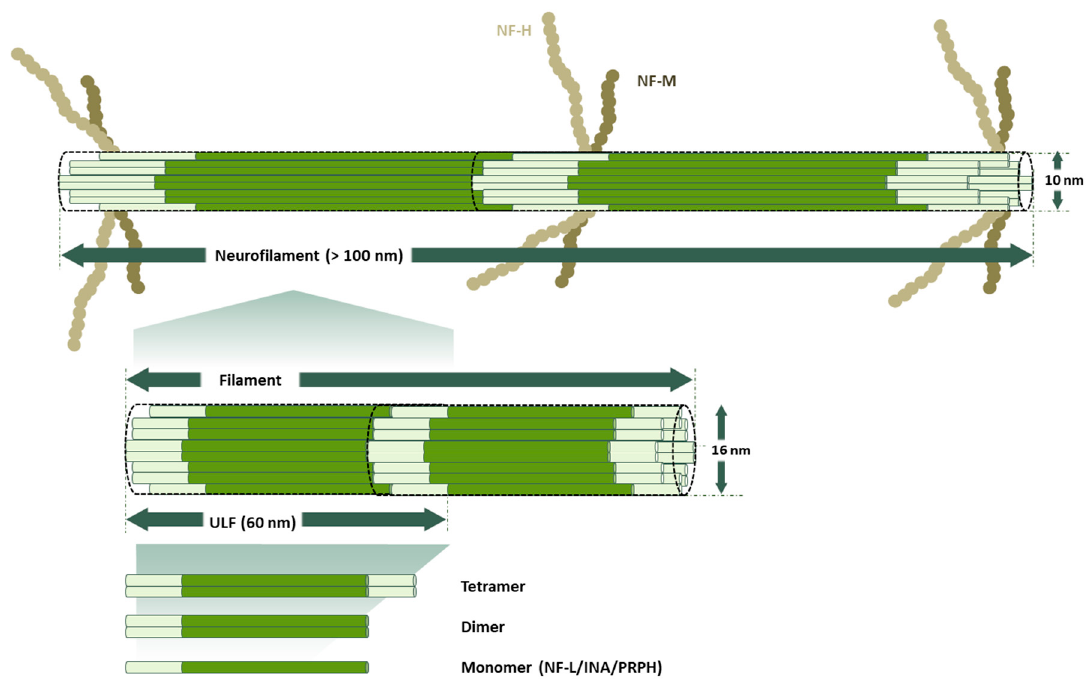
Figure 3. Self-assembly of neurofilaments. Monomers of NF-L, α -internexin (INA), or peripherin (PRPH) follow sequential steps to assemble into neurofilaments. First, monomers form head-to-tail coiled-coil dimers. Next, these dimers are aligned with opposite orientation to form a stable tetrameric complex without polarity. These tetramers then link end-to-end to form the unit-length filament (ULF), which expands 60 nm in length and 16 nm in width. Combinations of ULFs give rise to the filament. Finally, these filaments are helically twisted to build neurofilaments with a 10 nm diameter and more than 100 µ m in length [29]. Mature neurofilaments are modified by the continuous turnover of NFs, the lateral NF subunit exchange, and the incorporation of new, shorter filaments by the interaction with any other of the neuron-specific Intermediate filaments (IFs), such as NF-M or NF-H.